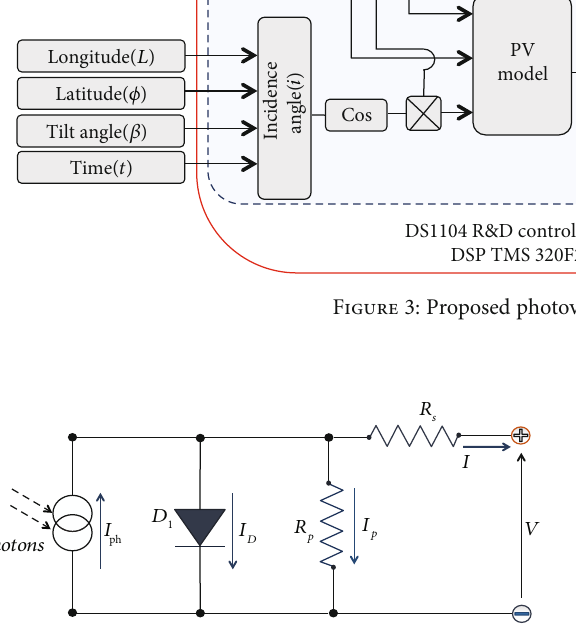
Figure 4: Equivalent circuit model of the 1D2R